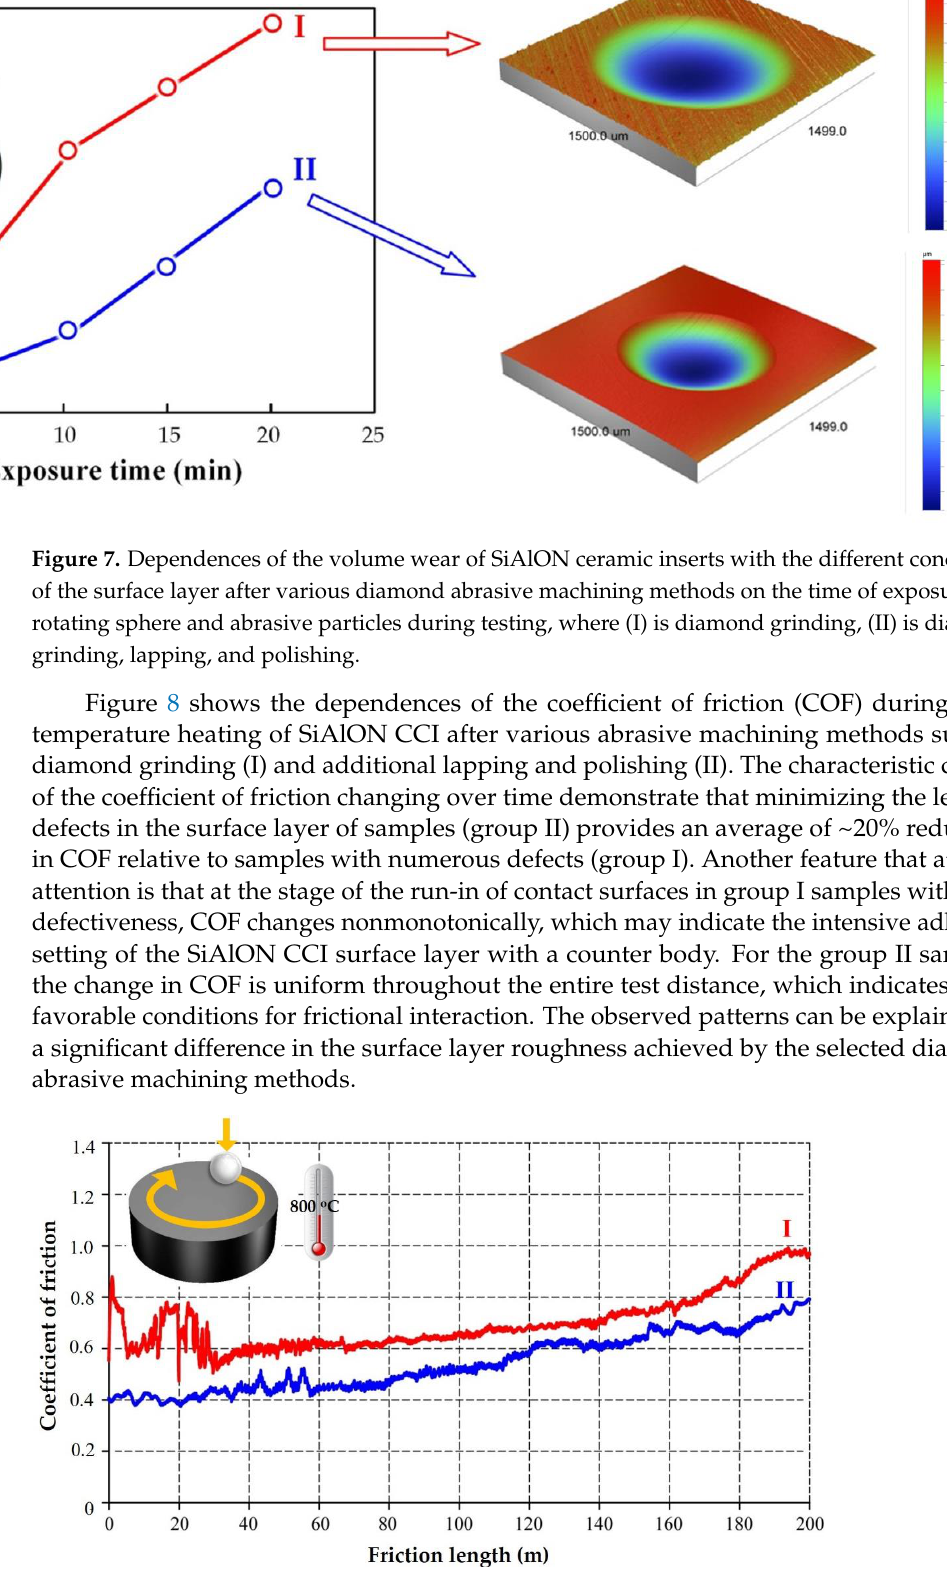
Figure 8. Dependences of the coefficient of friction during high-temperature heating of SiAlON ceramic inserts with different surface layer conditions on the length of the friction path, where (I) is diamond grinding, (II) is diamond grinding, lapping, and